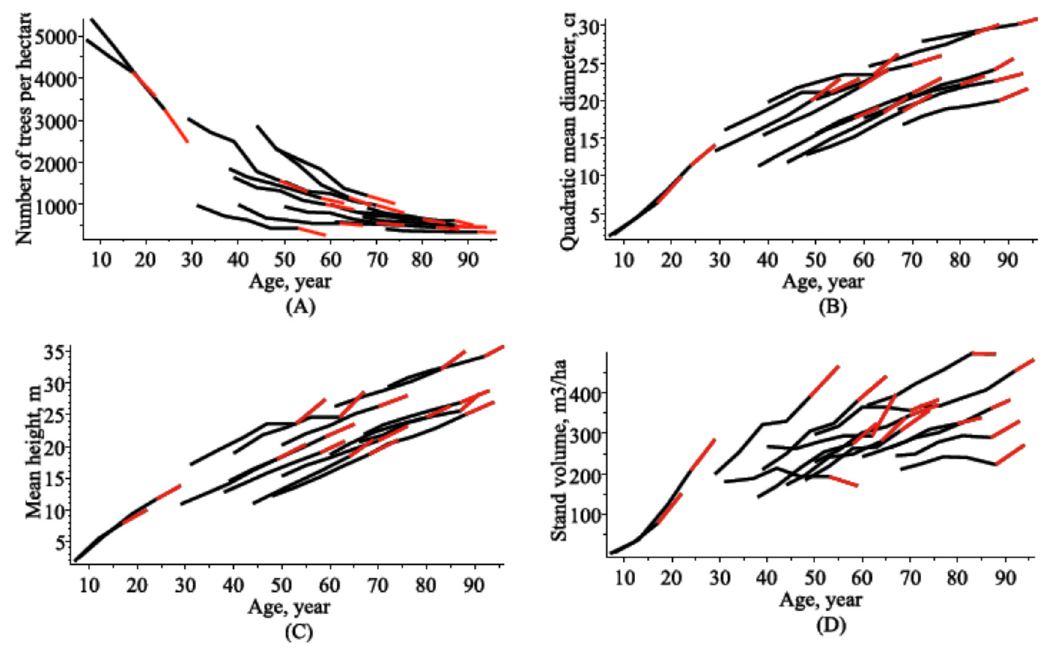
Figure 1. Observed datasets. Black–estimation dataset; red–validation dataset; ( A ) number of trees per hectare; ( B ) quadratic mean diameter; ( C ) mean height; ( D ) stand volume per hectare.